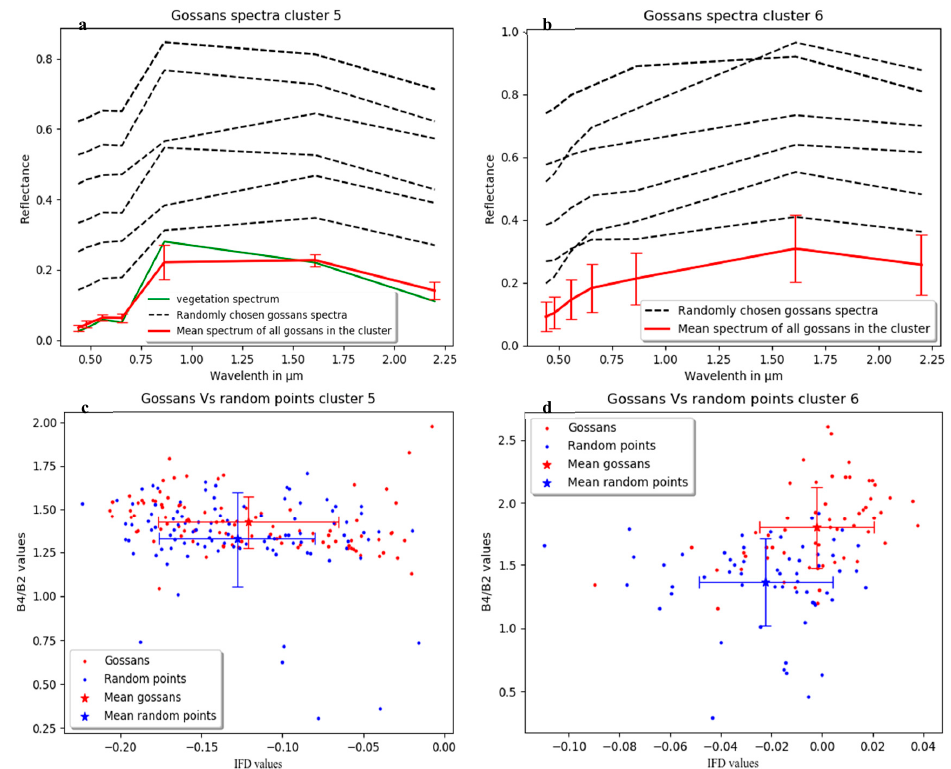
Figure 11. Mean spectrum of all gossans with 6 randomly chosen spectra for the clusters 5 ( a ) and 6 ( b ) (Offset for clarity). Vegetation spectrum added for comparison on the subfigure ( a ). Scatter plot of IFD values versus band ratio values for the gossans and randomly placed points for the clusters 5 ( c ) and 6 ( d ). A slight separation is possible on the latter.